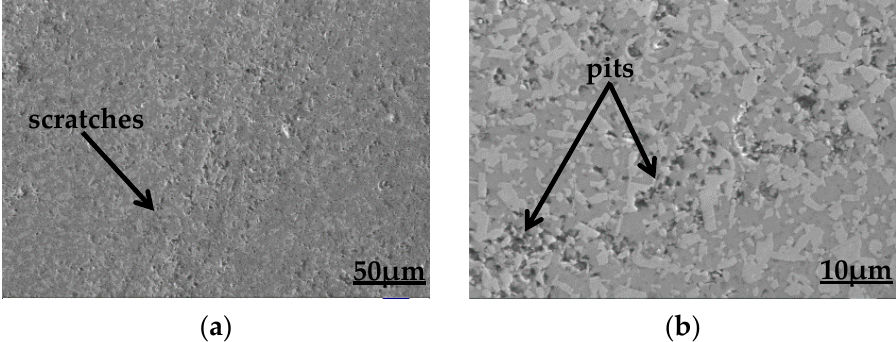
Figure 14. Wear morphology of the non-textured polished specimen: ( a ) magnification of 500; ( b ) magnification of 1500.